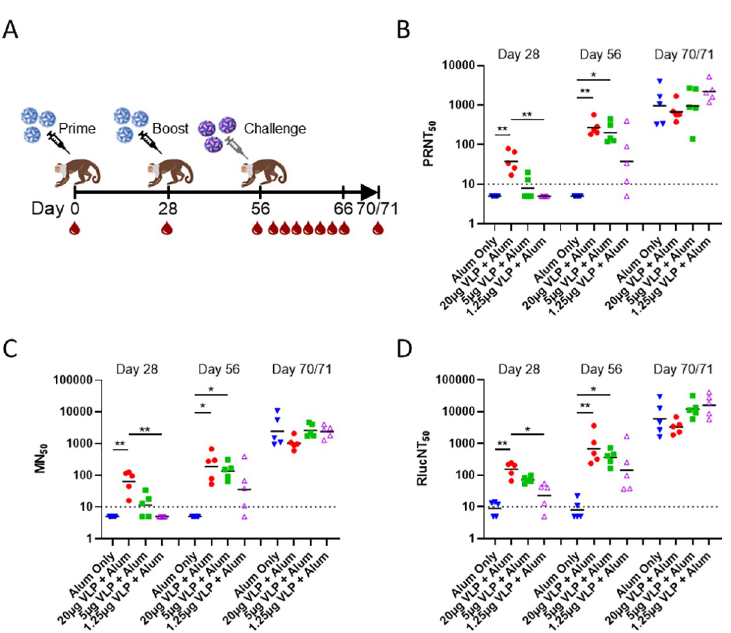
Fig 6. Experimental design and serum neutralizing antibody responses to Zika VLP vaccination in NHPs. (6A) Rhesus macaques (5 per group) were immunized on the indicated days with a dose titration of VLPs formulated